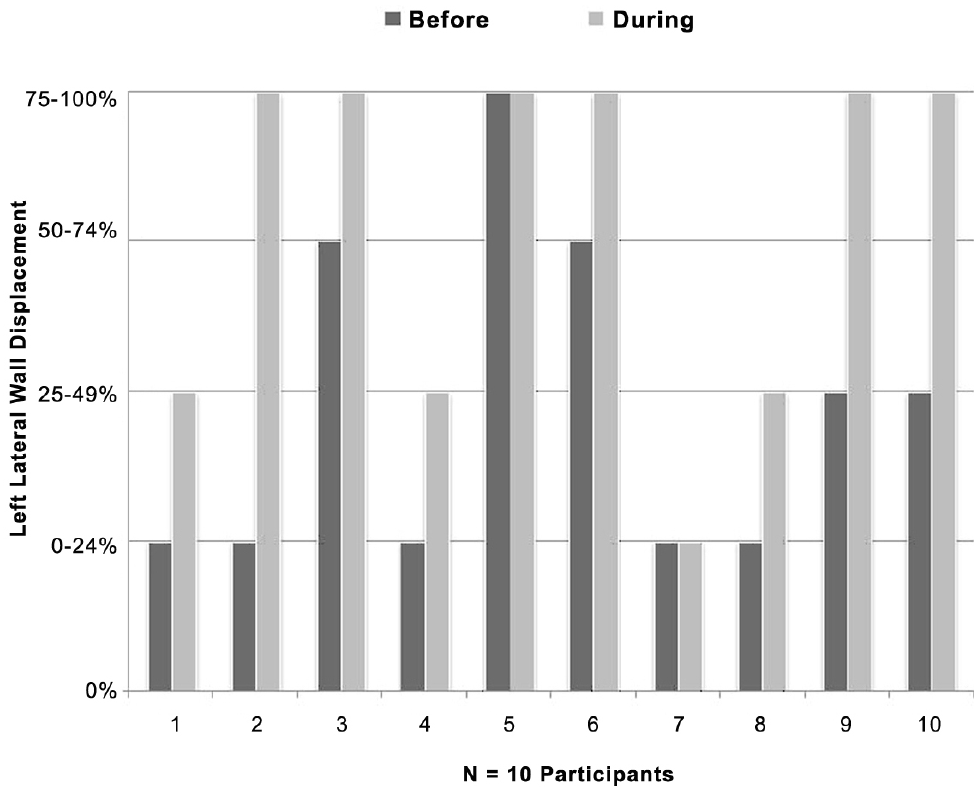
FIGURE 3- Maximum left lateral pharyngeal wall displacement before and after diagnostic therapy for all 10 participants